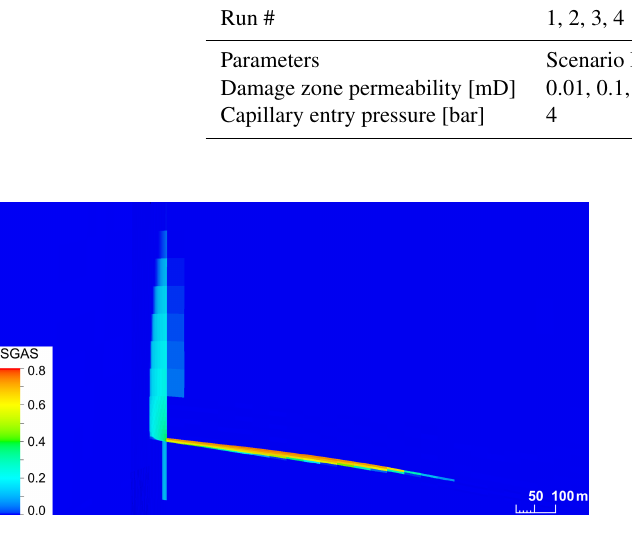
Figure 5. Exemplary gas phase saturation in the fault zone at day 1827 in run #11, scaled-up by 3 units in z axis. Gas flows from the storage formation to the damage zone is directed upwards within the damage zone.